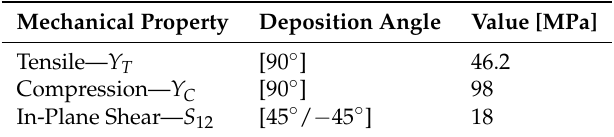
Table 5. Experimental data for unreinforced 3D-printed PLA